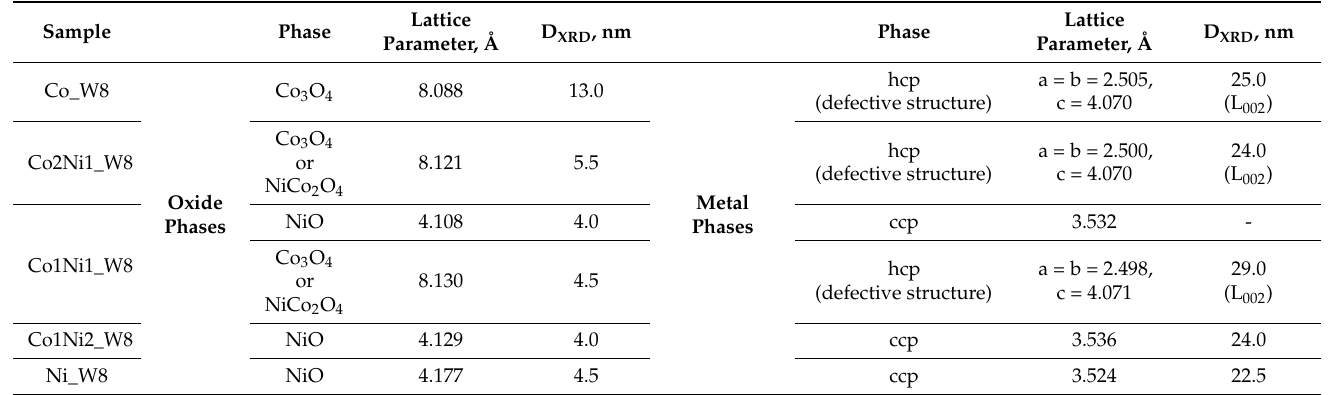
Table 1. Phase composition, lattice parameters, and DXRD size of Co-Ni-containing samples after calcination and